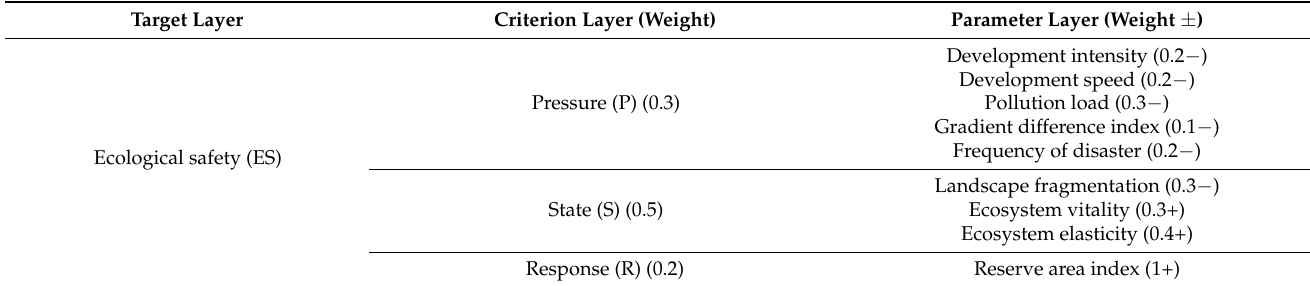
Table 1. Indicators used in the ES assessment